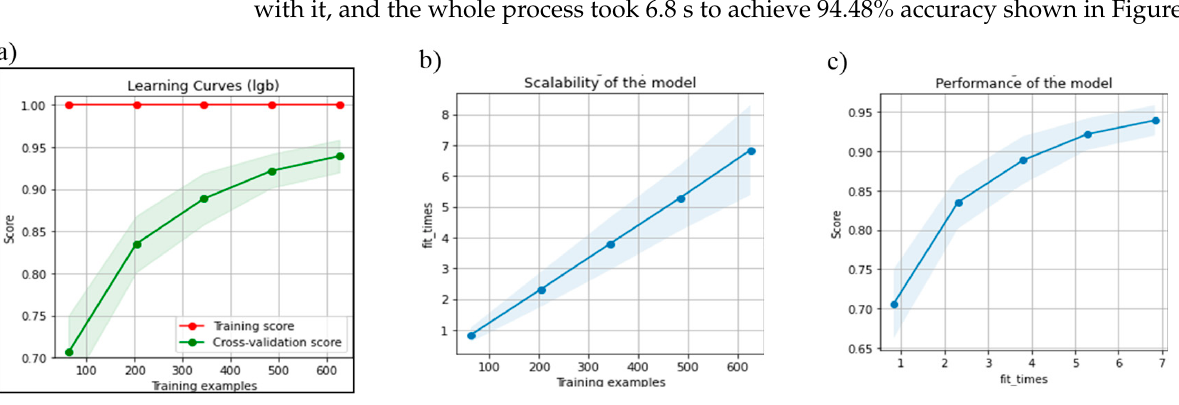
Figure 16. ( a ) Learning curves, ( b ) Scalability of the model, and ( c ) Performance of the model.